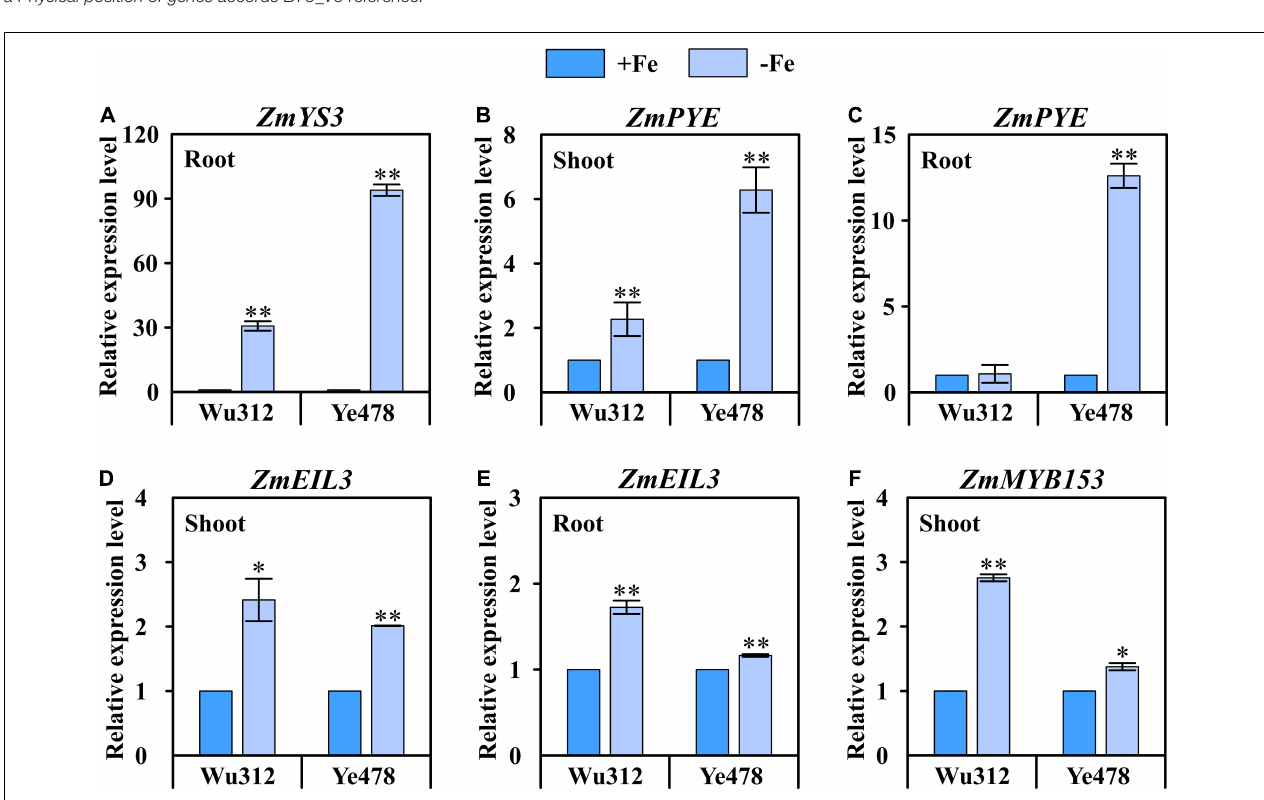
FIGURE 7 | Expression of four candidate genes in the shoots and roots of Fe-inefficient (Wu312) and Fe-efficient (Ye478) parents under Fe-deficient [–Fe: 30 µ M Fe(III)-EDTA] and Fe-sufficient [+Fe: 200 µ M Fe(III)-EDTA] conditions. (A) ZmYS3 expression in the roots, (B,C) ZmPYE and (D,E) ZmEIL3 expression in the shoots and roots, (F) ZmMYB153 expression in the shoots. * and ** indicate significant difference between the –Fe and +Fe treatments at p < 0.05 and p < 0.01,